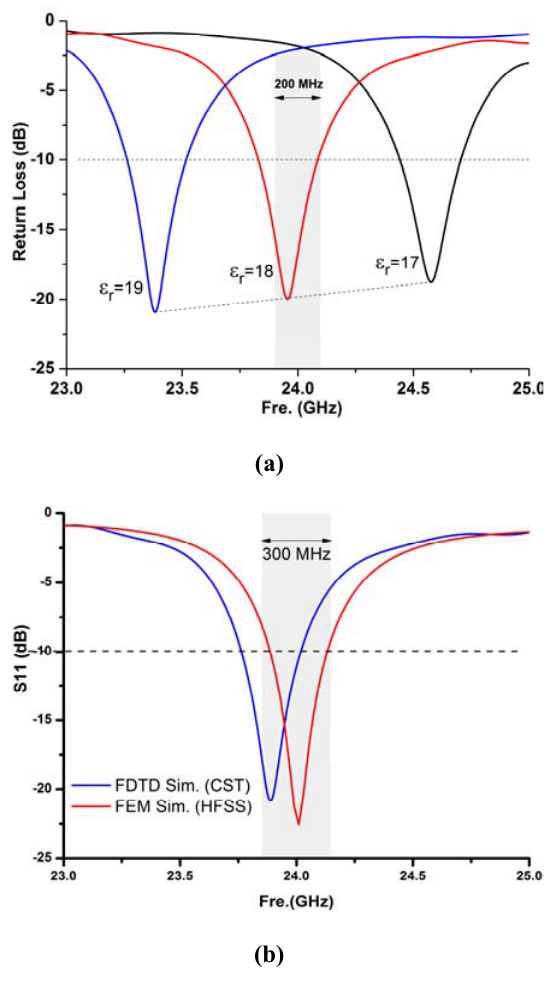
Figure 3: Reflection coefficient: (a) CST study and (b) optimal NDRA where h s =18.